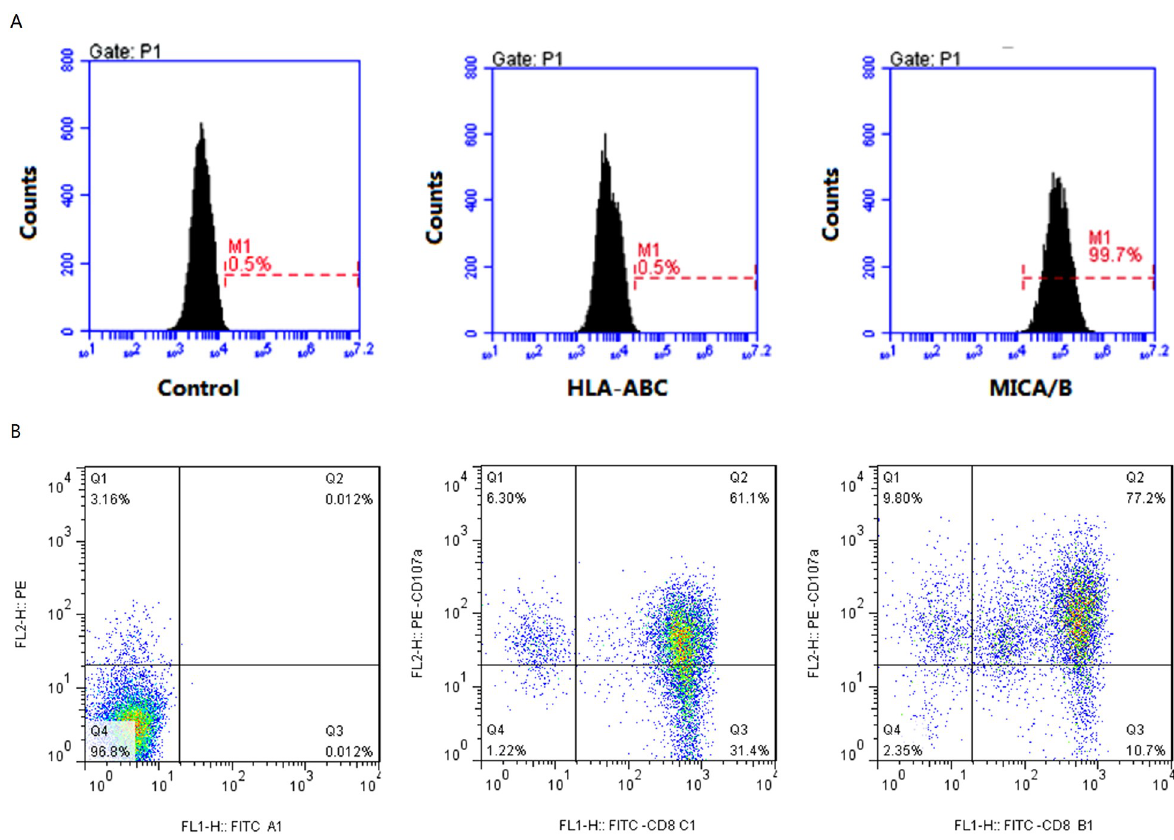
Fig 4. K562 cells induce CD8 + CIK cell degranulation. A, Detection of HLA-ABC and MICA/B antigenexpressionon K562 cell surface by flow cytometry. B, CD8+ CIK cells were mixed with K562 cells were cultured 4 hr and subjectedflow cytometry analysisof CD107aexpression. Left: control group with no stimulationand fluorescence-labeledantibody addition;Middle:CD8+ CD107a+cell The rate of CD8+ CIK cell to K562 cells was 1: 1. Right: CD8+ CD107a+cell The rate of CD8+ CIK cell to K562 cells was 10: 1.